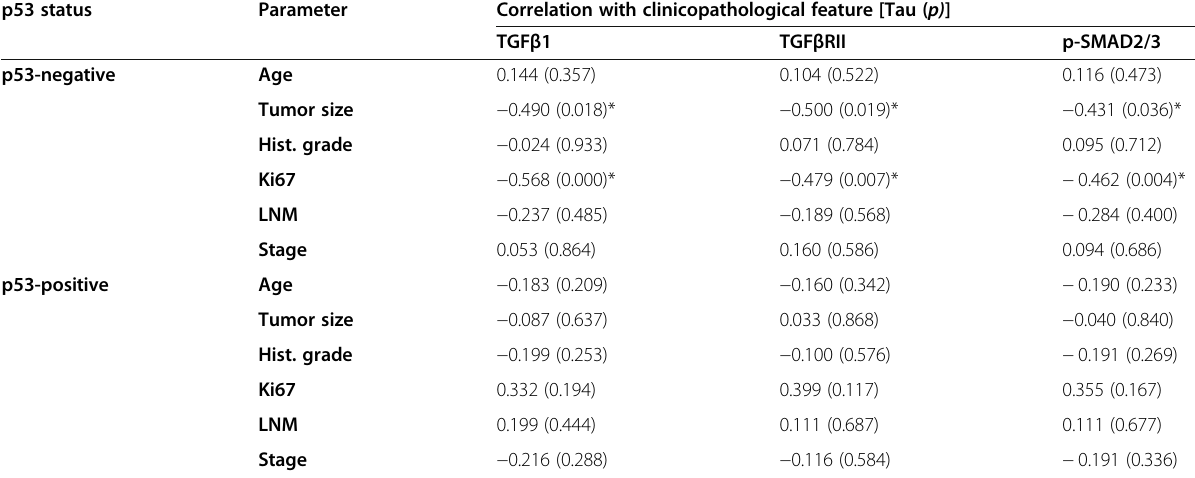
Table 5 Correlation between clinicopathological parameters at diagnosis and intratumor staining for TGF β 1 components according to p53